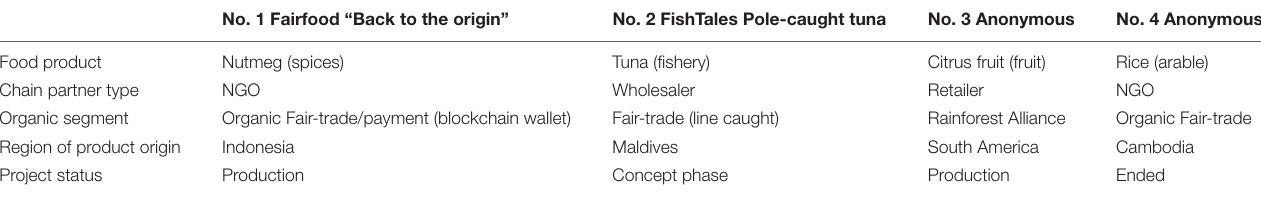
TABLE 2 | Overview of selected